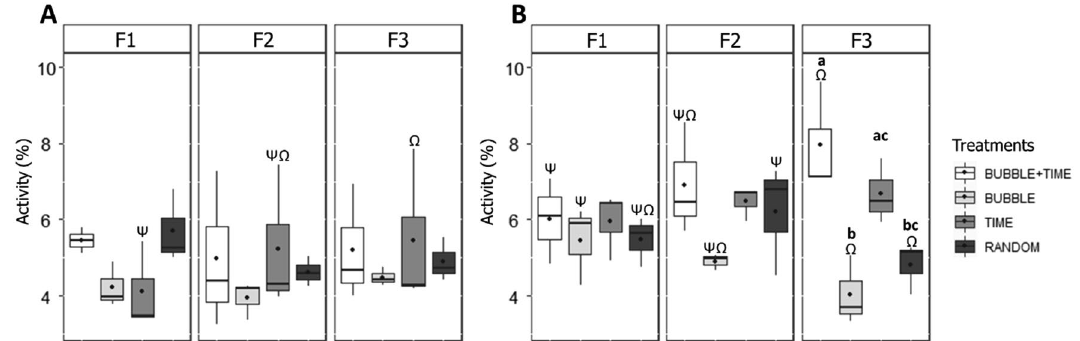
Figure 3. Median (quartiles: 25%, 75%) percentage of fish group activity (% of differing pixels between two successive images) in the whole tank during the 6-min period preceding feed delivery. Results are given for each treatment and for the three feedings on ( A ) day 1 and ( B ) day 12 of conditioning. F1, F2 and F3 correspond to the three feedings analysed. The black point inside boxes represents the mean value. Different latin letters indicate significant differences between treatments, and different greek letters indicate differences between feedings ( P < 0.05; Tukey post-hoc